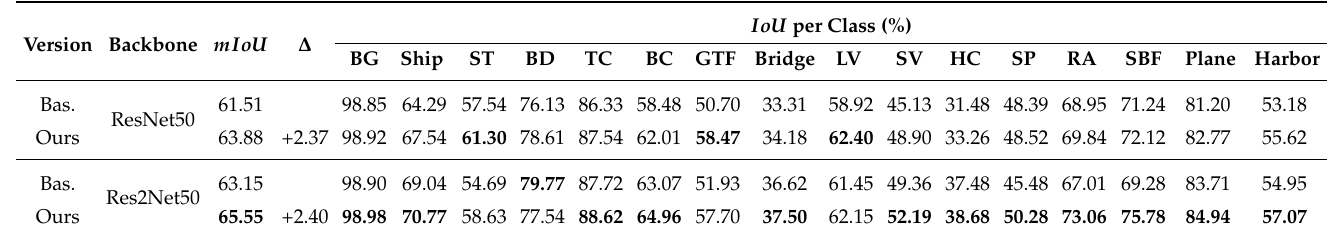
Figure 8. The visualization results of ablation experiments. Table 6. The comparison of different feature extractors on the iSAID dataset. The best results are highlighted in bold